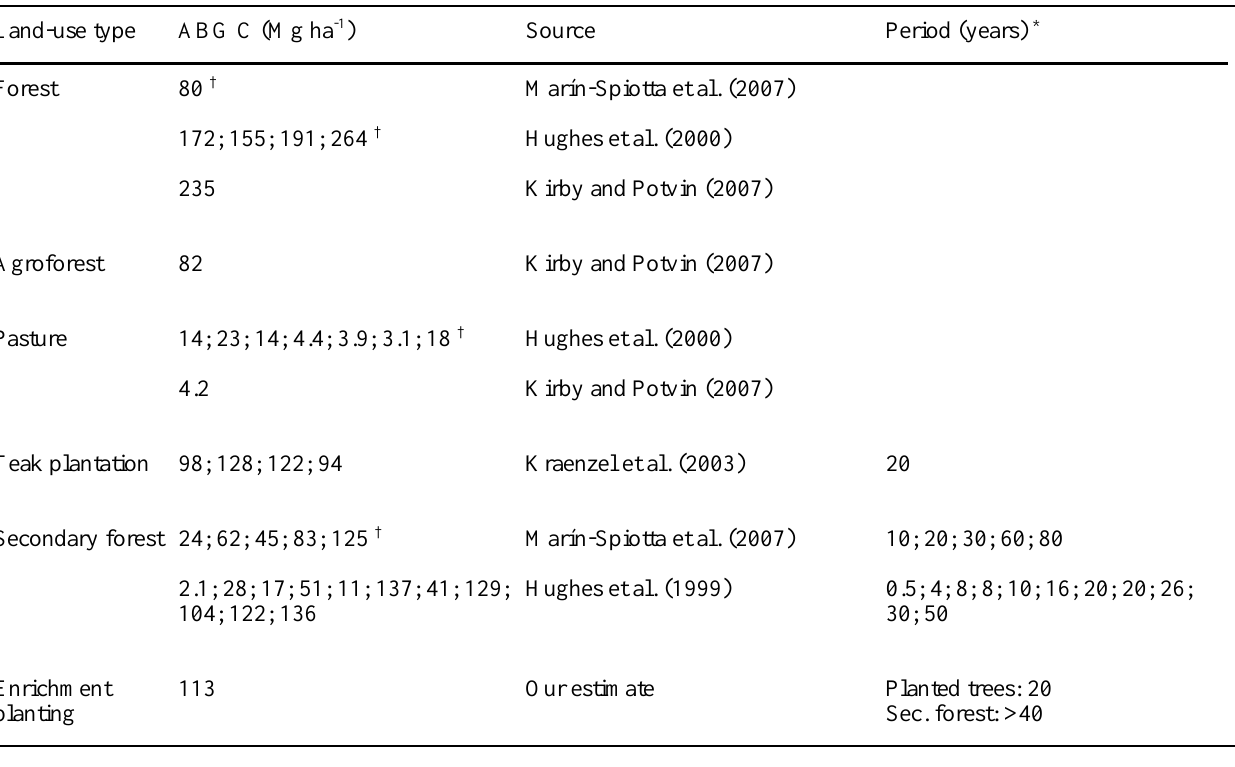
Table 3. Values, references, and timescales for aboveground (ABG) C storage for different land-use types in the humid